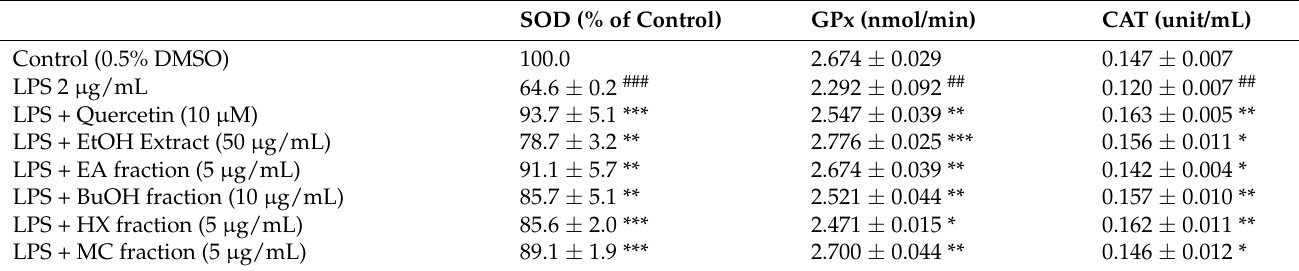
Figure 2. Effects of the EtOH extract and fractions of white mulberry fruits on reactive oxy- gen species (ROS) generation in LPS-stimulated RAW 264.7 macrophages. Data are expressed as means ± SD (n = 5). *** p < 0.001 vs. LPS treatment. Table 2. Antioxidant enzyme capacities of EtOH extract and fractions of white mulberry fruits in LPS-treated RAW 264.7 macrophages a